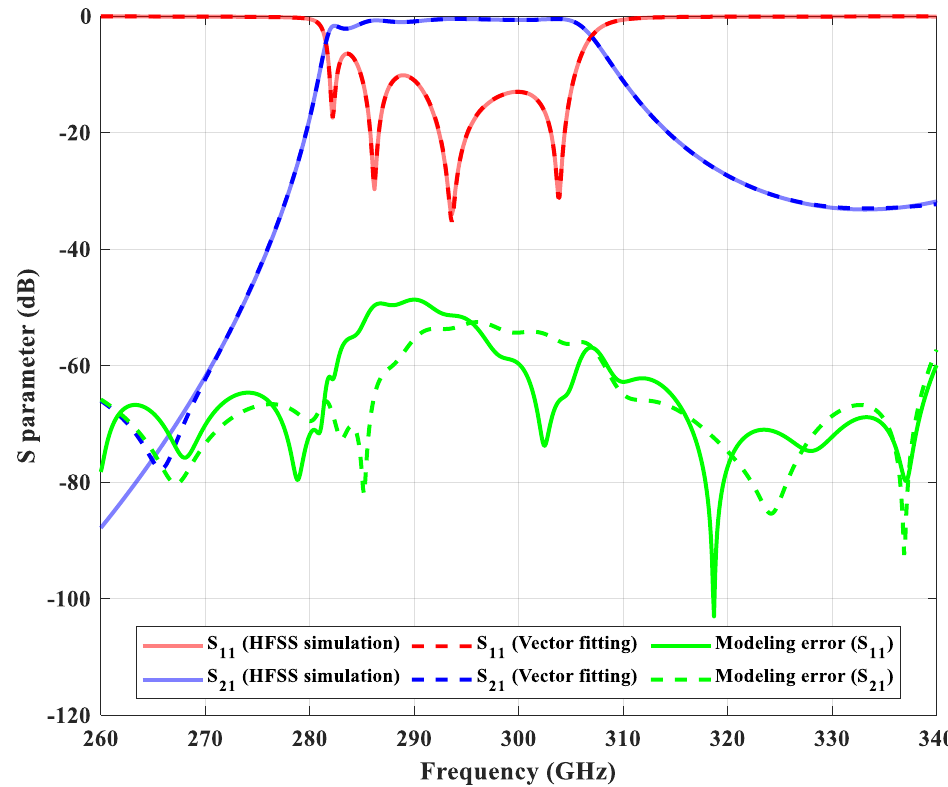
Figure 3. The comparison between the simulated S parameters of the filter and the corresponding vector fitting model.